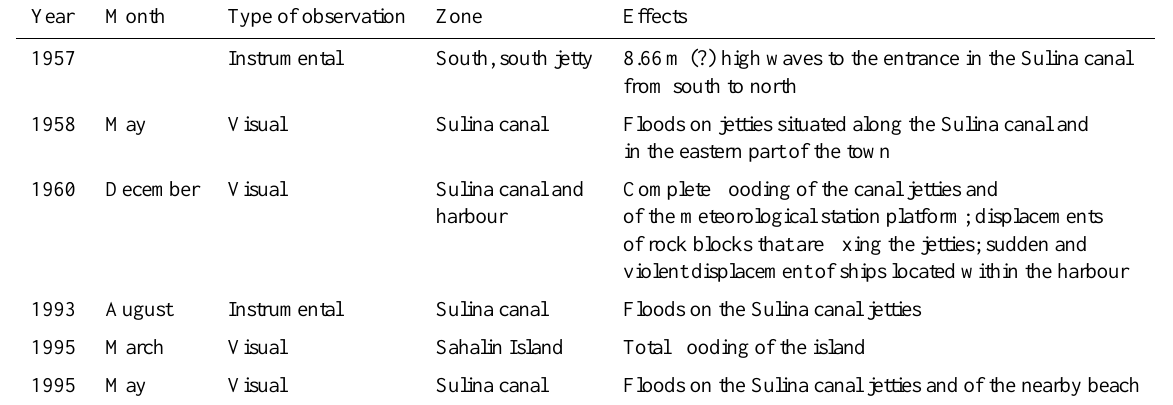
Table A1. Elements of sea wave cases observed on the Romanian Black Sea coast from 1957 to 1995. Data were collected by Oaie et al. (2006b) who put forward the hypothesis that some of the cases might be considered tsunamis. However, the data available are quite uncertain. For example, in all the cases listed there is a lack of data about the seismic activity as well as about parameters such as wave period and runup distance. Therefore, the cases are listed here with the purpose of initiating possible further